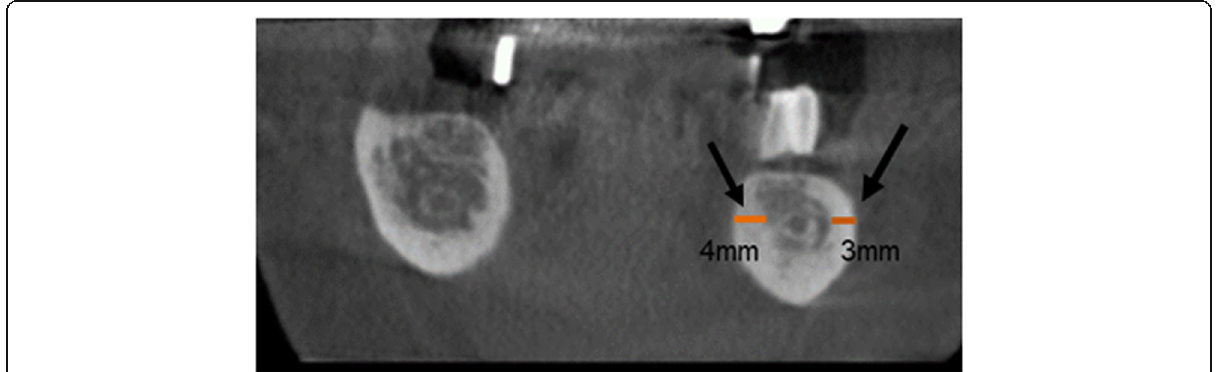
Fig. 3 Section of CBCT image of region 36 with buccal and lingual measurement of cortical bone thickness